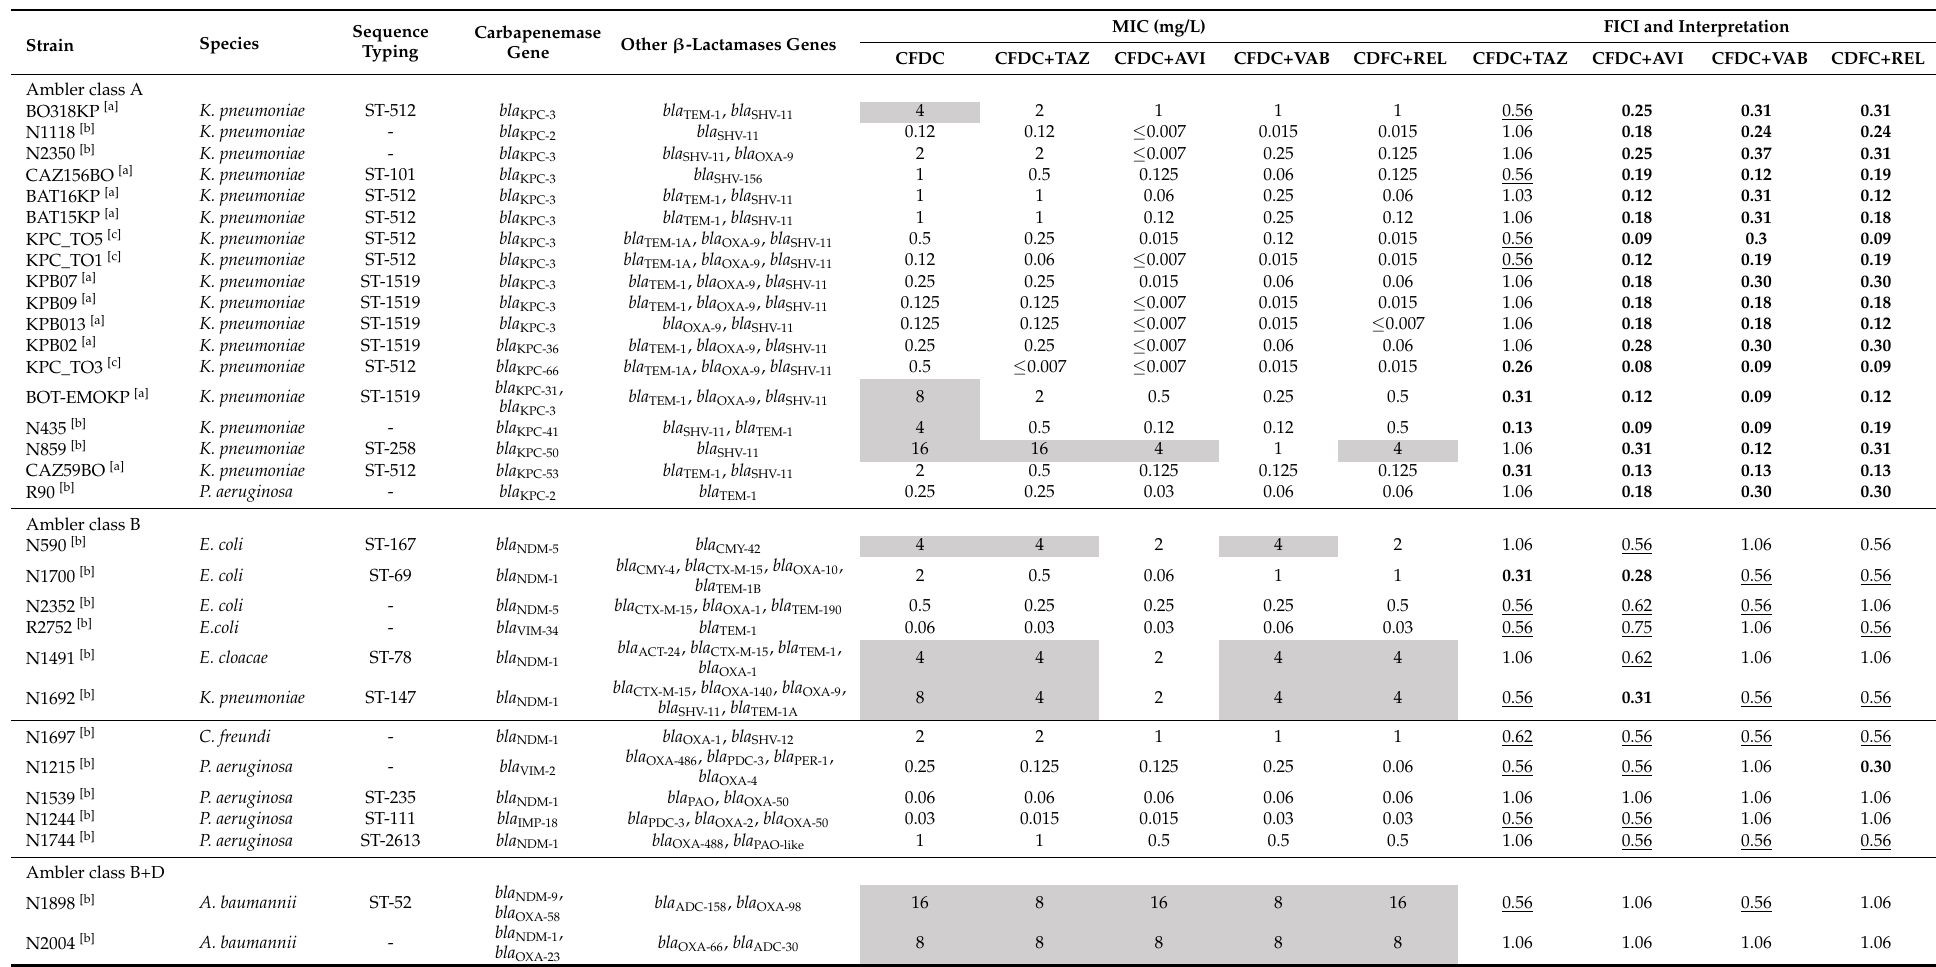
Table 1. FICIs of tazobactam, avibactam, vaborbactam and relebactam in combination with cefiderocol against carbapenemase-producing Gram-negative